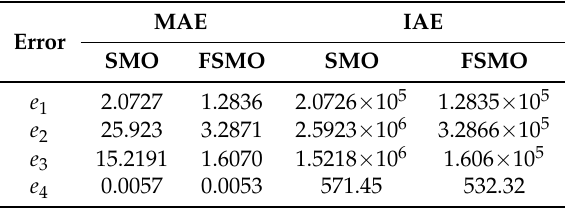
Table 1. Error criteria for sliding-mode observer (SMO) and fuzzy sliding-mode observer (FSMO). MAE = Mean Absolute Error; IAE = Integral Absolute